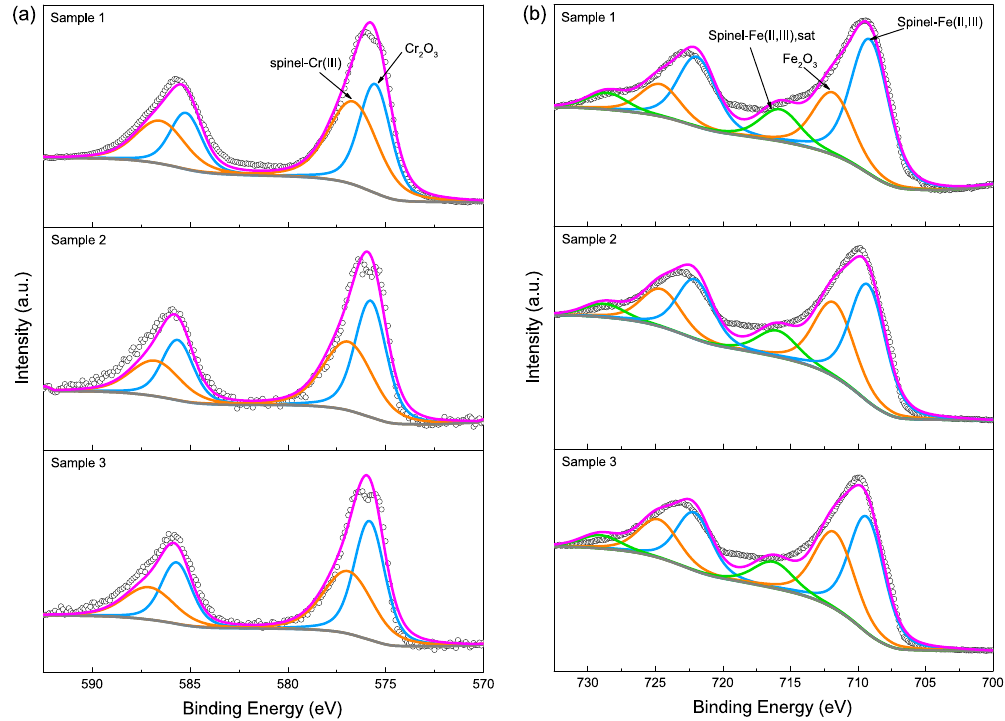
Figure 4. XPS spectra of: ( a ) Cr 2 p , ( b ) Fe 2 p . In each panel, the spectra of the three samples are illustrated. Each pair of doublet peaks were illustrated with identical color. The scatter plots are experimental results, while the magenta and grey lines represent the fitting envelopes and backgrounds,